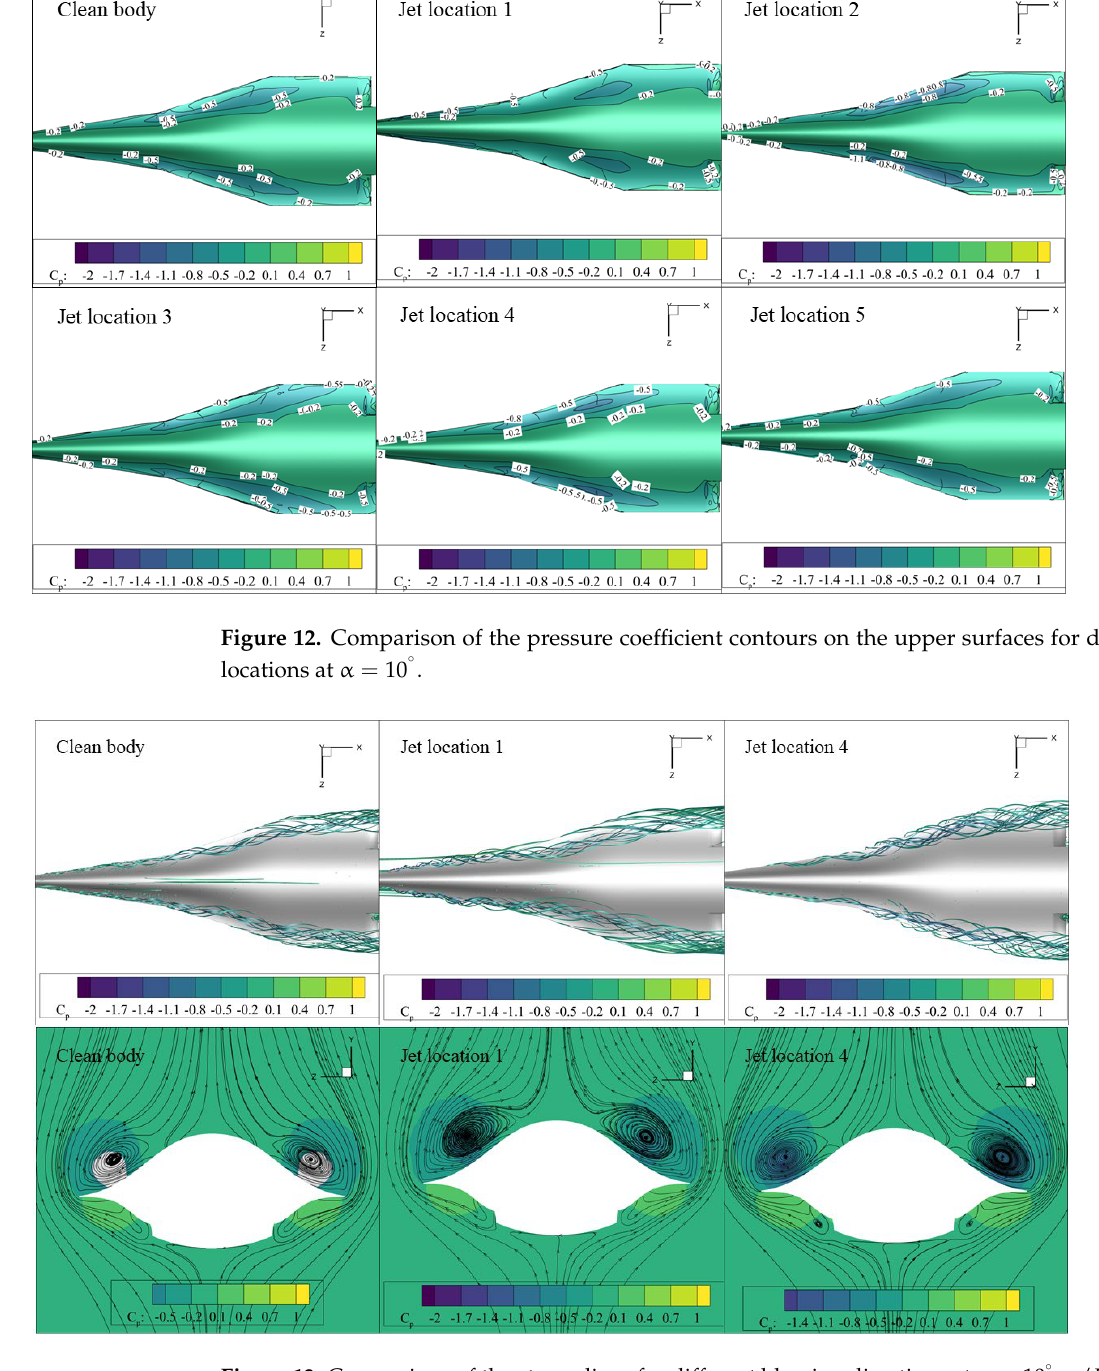
, 0.6. ° α = 10 𝑥𝑥 / 𝐿𝐿 0 =